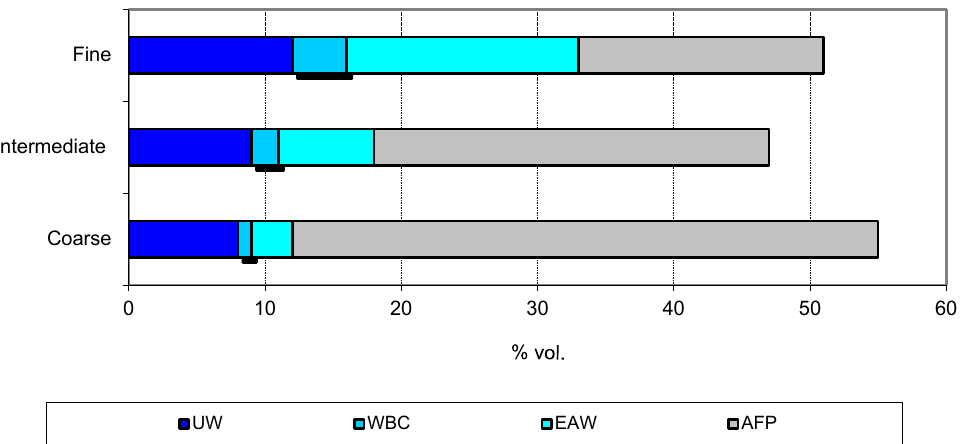
Figure 6. Mean overall porosity of the three groups.